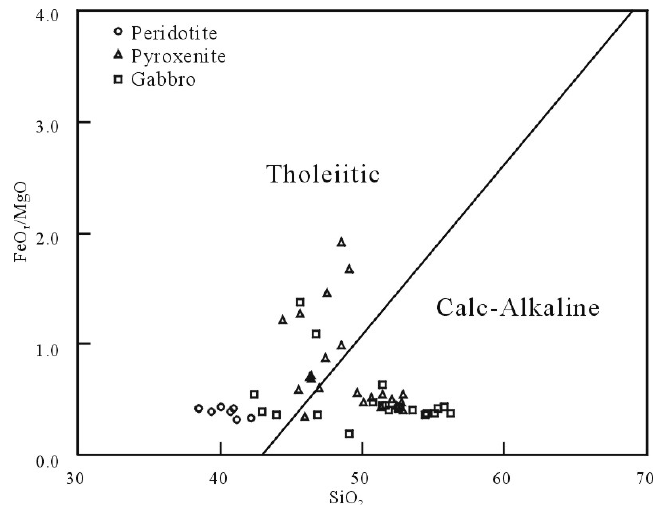
Figure 5. The petrochemical series classification diagram from [40].